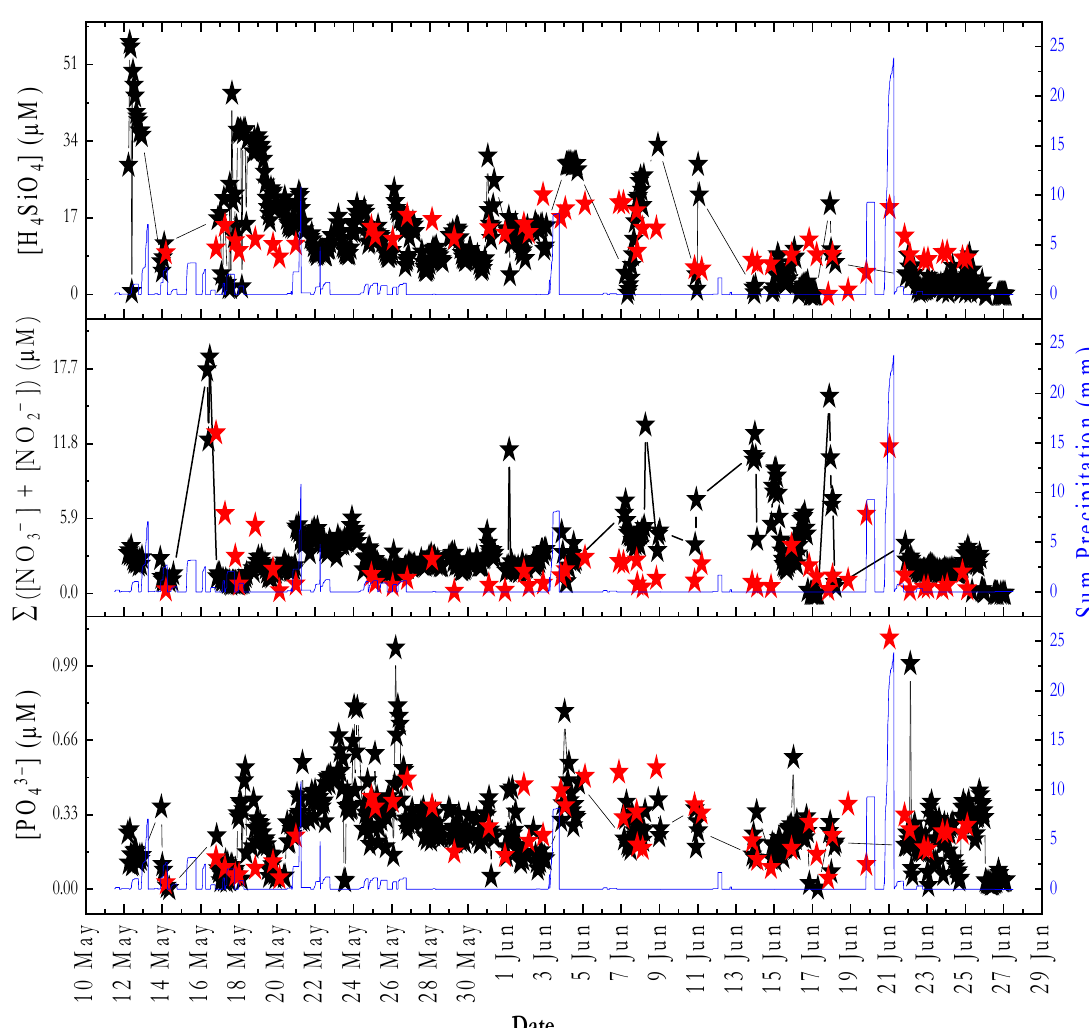
Figure 8. Time series data for the period of 12 May to 27 June 2021 of on-site PO 43 − , Σ (NO 3 − + NO 2 − ), and H 4 SiO 4 analyzer measurements (black stars) obtained from an on-site analyzer and from discrete samples analyzed using a laboratory-based segmented flow analyzer (red stars). Sum precipitation (i.e., rainfall data) were shown as blue lines. The nutrient concentrations were calculated by applying linear regression using four onboard standards. Considering all the on-site data, the mean PO 43 − concentration was 0.26 µ M ( ± 0.15); a minimum value of 0.0012 µ M (<LOD), and a maximum value of 1.07 µ M. The Σ (NO 3 − + NO 2 − ) concentrations ranged from 0.0025 (<LOD) to 18.6 µ M, and the mean was 2.9 µ M ( ± 2.3). The H 4 SiO 4 concentrations ranged from 0.001 µ M (<LOD) to 55.9 µ M; the mean was 12.2 µ M ( ± 10.4). For all data points of discrete samples (Figure 8, red stars), PO 43 − concentrations were in the range of 0.03–1.11 µ M, and the mean was 0.27 ± 0.18 µ M ( n = 51). The Σ (NO 3 − + NO 2 − ) concentrations were in the range of 0.17–12.6 µ M, and the mean value was 1.96 ± 2.51 µ M. The H 4 SiO 4 concentrations were between 0.007 µ M (<LOD) and 27.1 µ M, and the mean value was 11.1 ± 4.9 µ M. As one measurement cycle takes a total of 66 min, comparisons between the on-site data and the discrete samples (Figure S5) were made for the data points within a 30 min time interval. For PO 43 − data points ( n = 21) (Figure S6a), a positive Pearson’s correlation coefficient of 0.6534 was obtained. For Σ (NO 3 − + NO 2 − ) data points ( n = 17) (Figure S6b), two clear outliers were excluded from the correlation plot. A positive Pearson’s correlation coefficient of 0.45 was obtained. A positive Pearson’s correlation coefficient of 0.47 was determined for the H 4 SiO 4